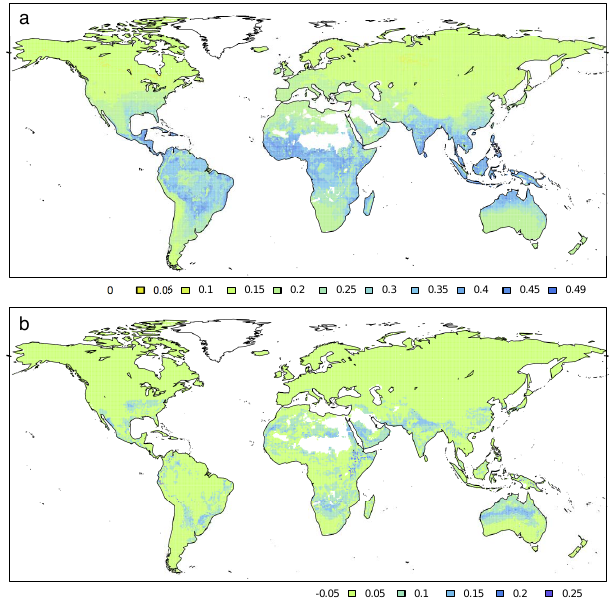
Figure 3. Decomposition fraction modifying factor (fmf) under ref- erence climatic conditions (a) and the difference in fmf between reference and target conditions (b) . fmf summarizes the effects of temperature, humidity, soil reaction, and oxygen availability on the decomposition